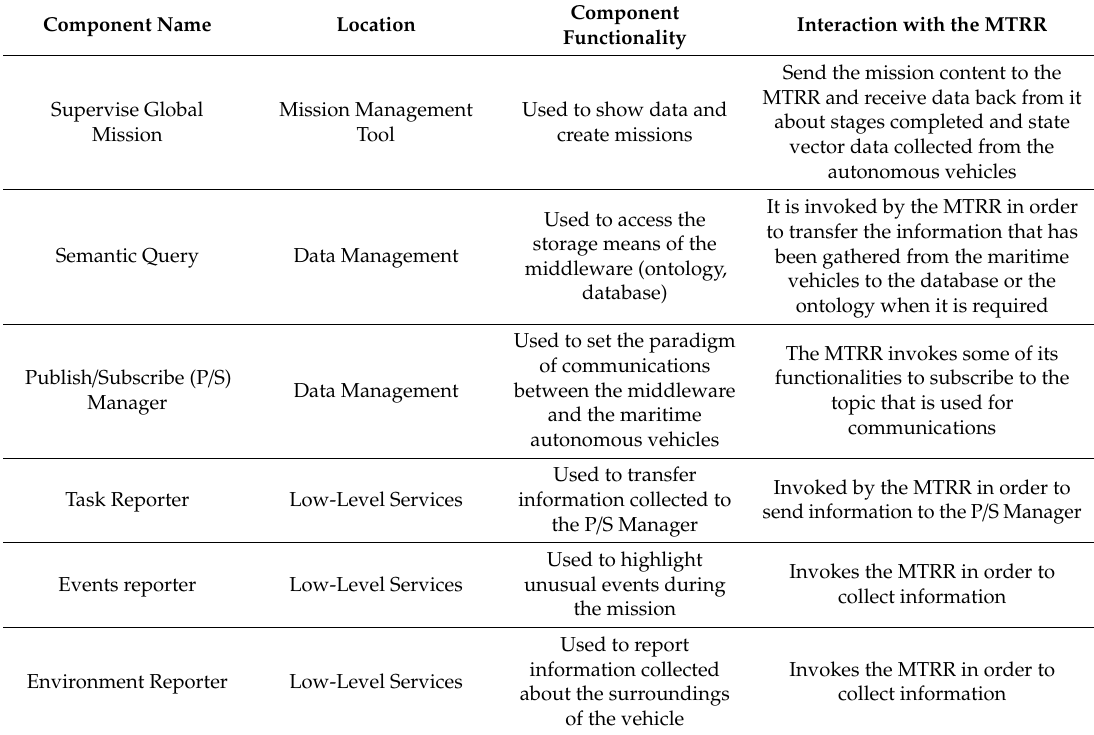
Table 1. Relations between the Missions and Tasks Register and Reporter (MTRR) and other middleware